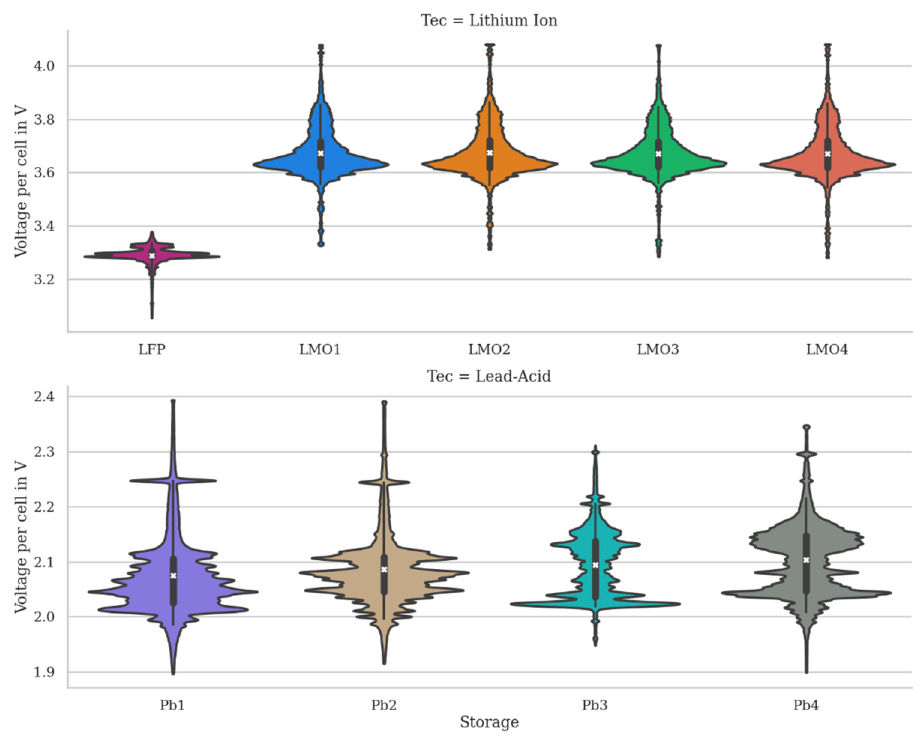
Figure 9. Distribution of the cell voltage for the different battery units.